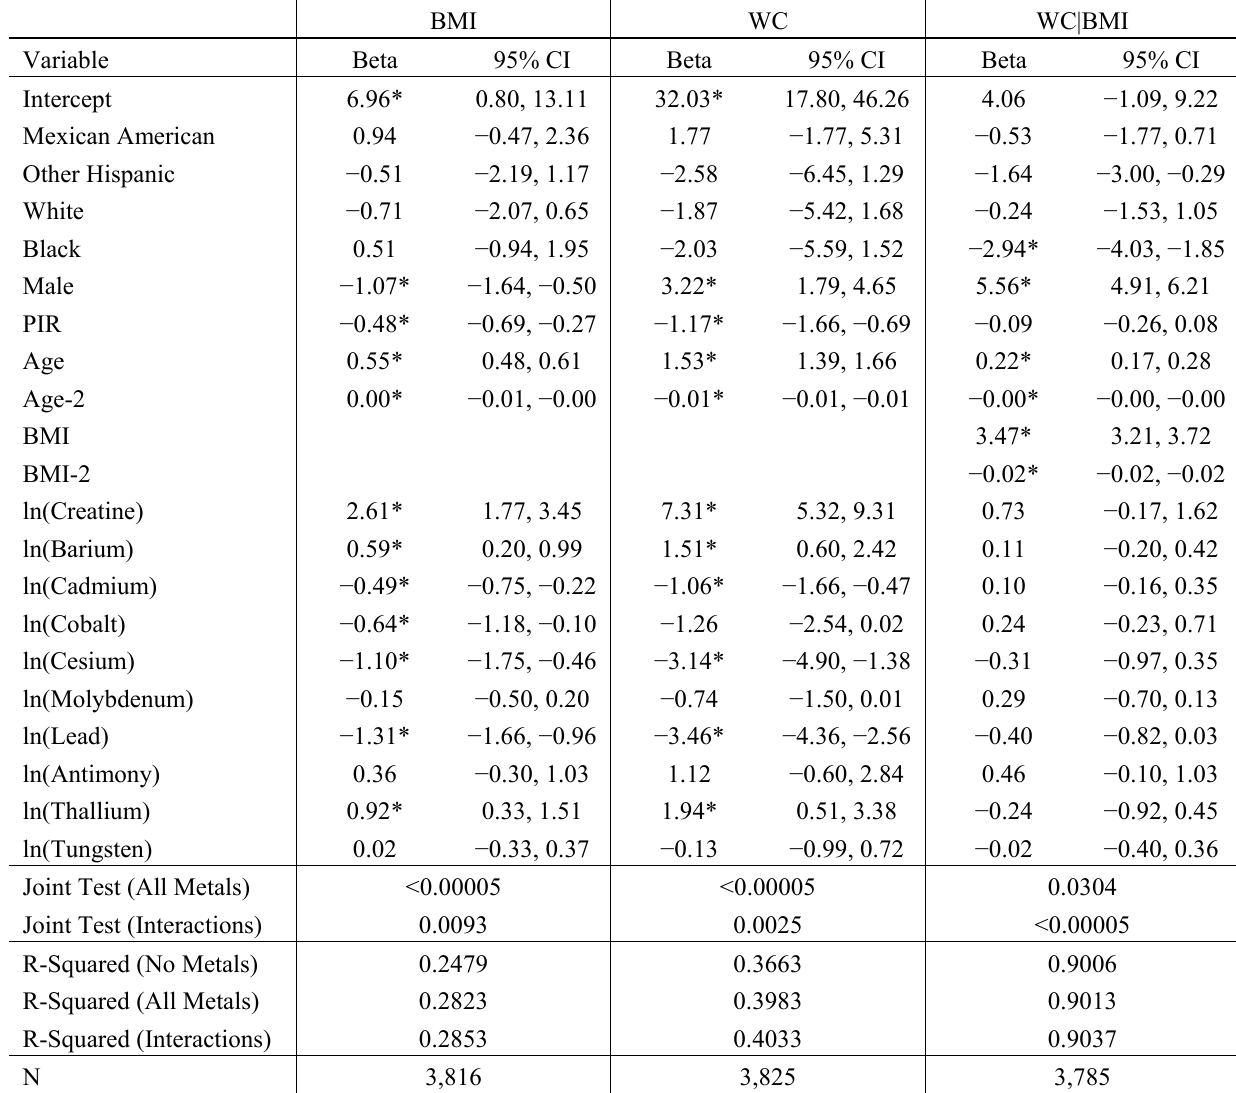
Table 3. Regression Models for All